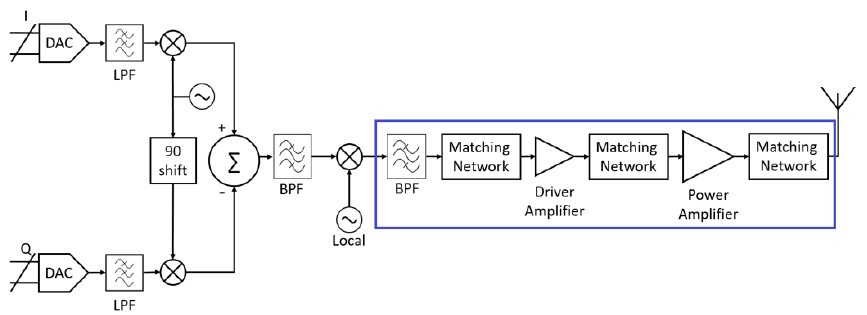
Figure 1. Typical signal conditioning stage.